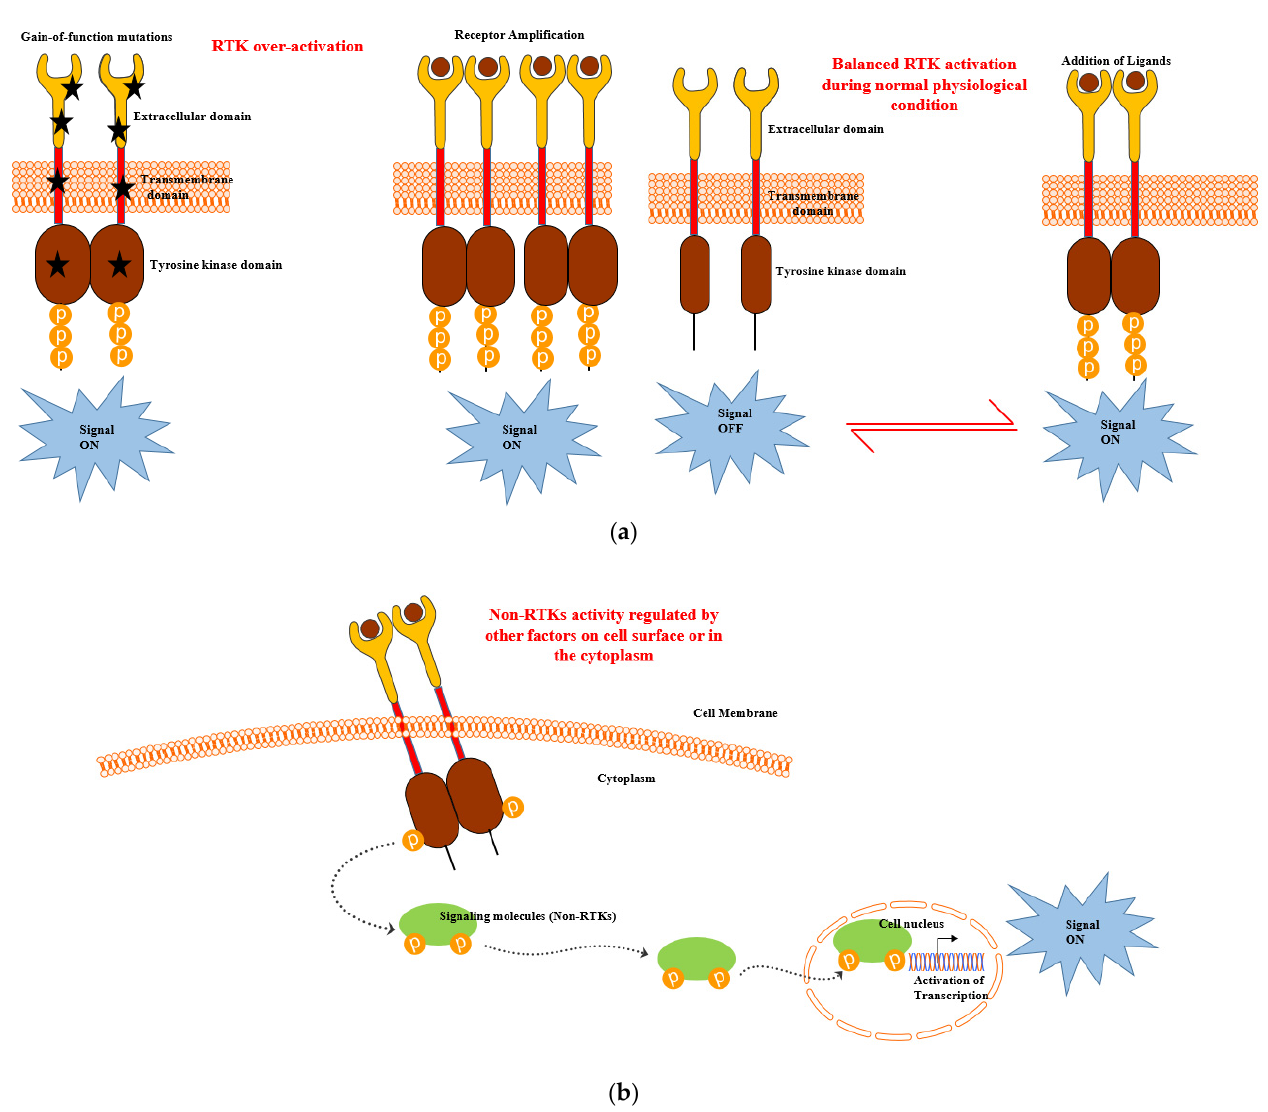
Figure 2. ( a ) Receptor tyrosine kinase (RTK) and ( b ) nonreceptor tyrosine kinase (NRTK) activation during leukaemia development and progression [10,31].